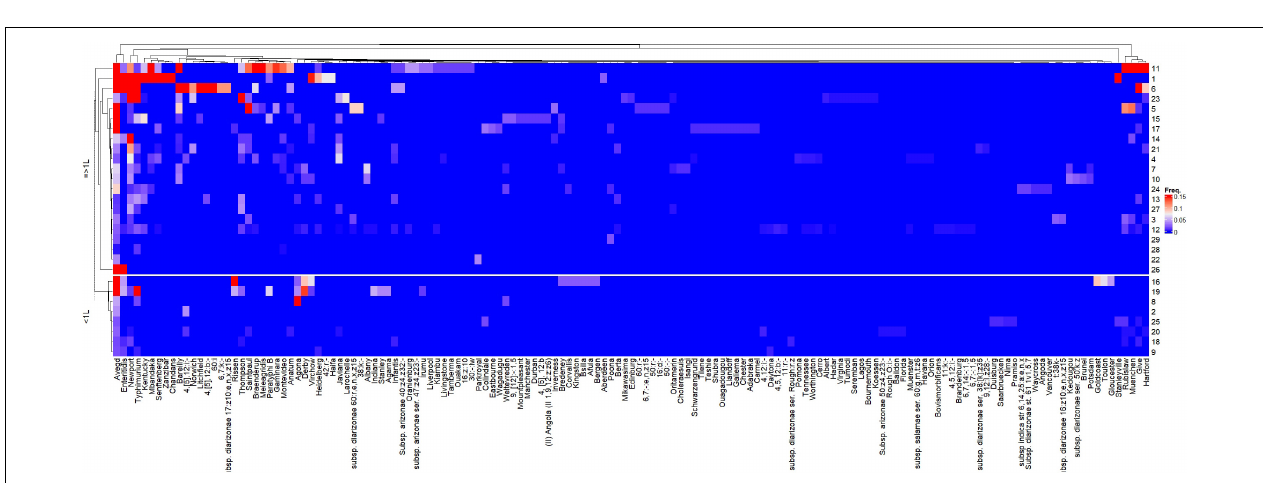
FIGURE 6 | Heatmap of the relative frequencies of Salmonella enterica serovars isolated from non-recycled water sources according to the human development index (HDI) of countries associated with 26 peer-reviewed scientific publications between the years 2015 and 2020. The heatmap was built in R (package